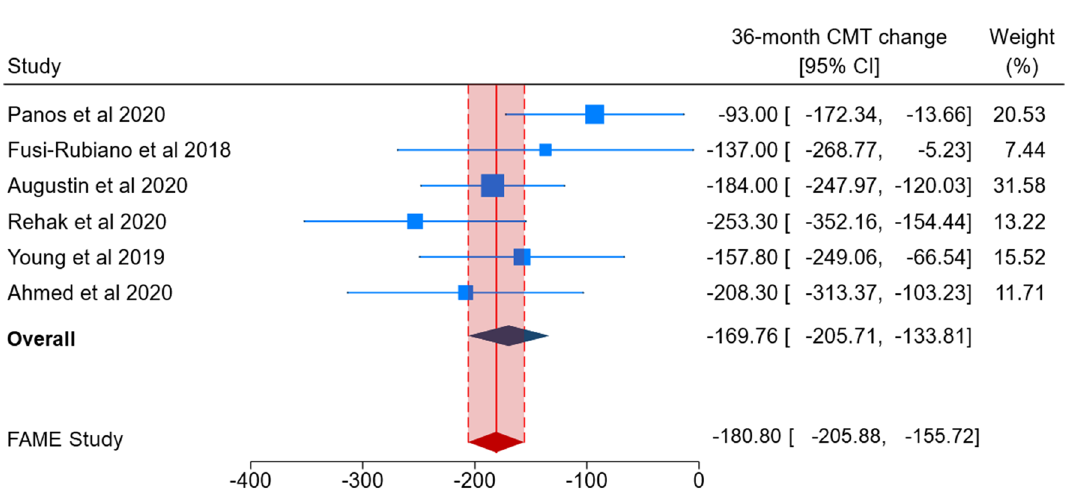
Figure 5. A forest plot showing 36-month central macular thickness (CMT) change, reported as Mean Difference (MD) with 95% confidence interval (CI), in real-world studies and 36-month foveal thickness change in the FAME